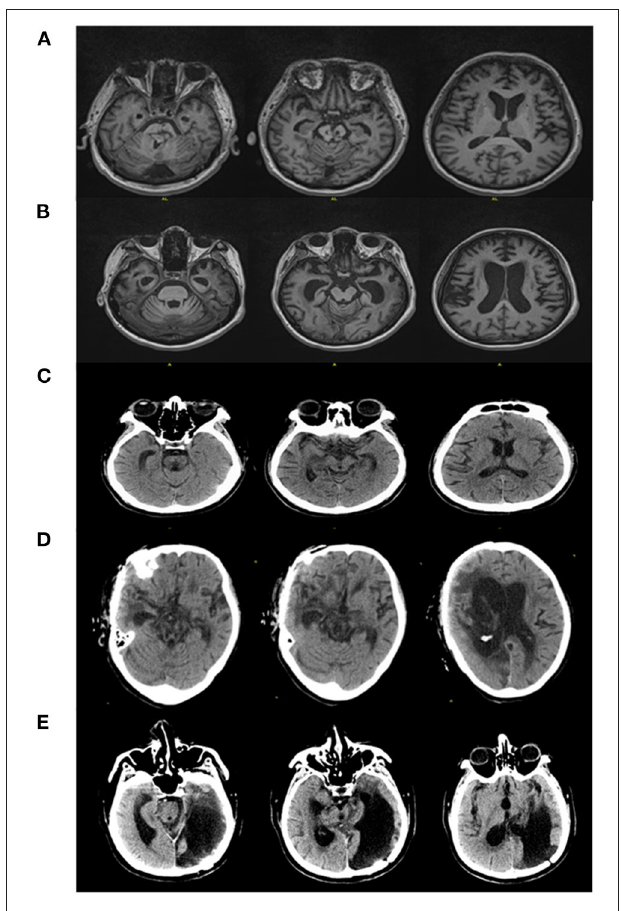
FIGURE 1 | CT/MRI findings of patients. (A) MRI demonstrated brainstem malacia, brain atrophy (Patient 1). (B) MRI demonstrated whole-brain atrophy (Patient 2). (C) CT showed diffuse axonal injury, brainstem malacia (Patient 3). (D) CT showed postoperative changes of severe TBI, diffuse axonal injury, and brain stem malacia (Patient 4). (E) CT showed postoperative changes of severe TBI, brain stem malacia, and malacia of left occipital lobe and temporal lobe (Patient